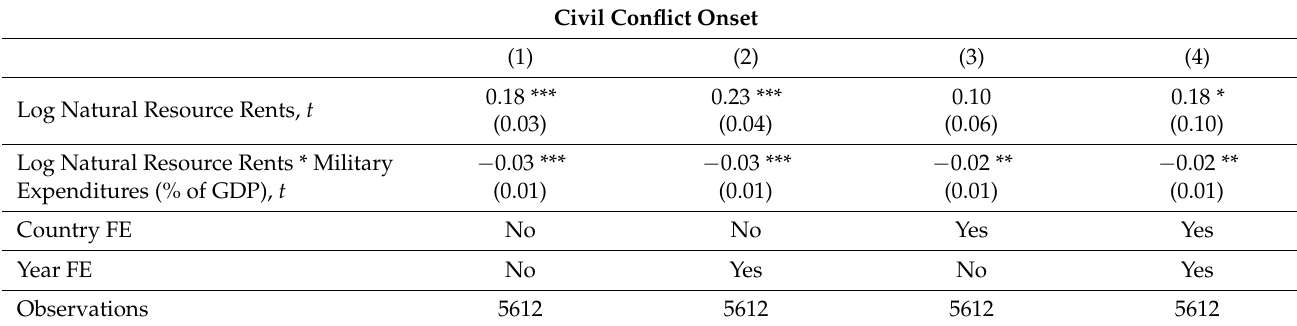
Table 4. Robustness: No Scaling of Natural Resource Rents by GDP. Civil Conflict